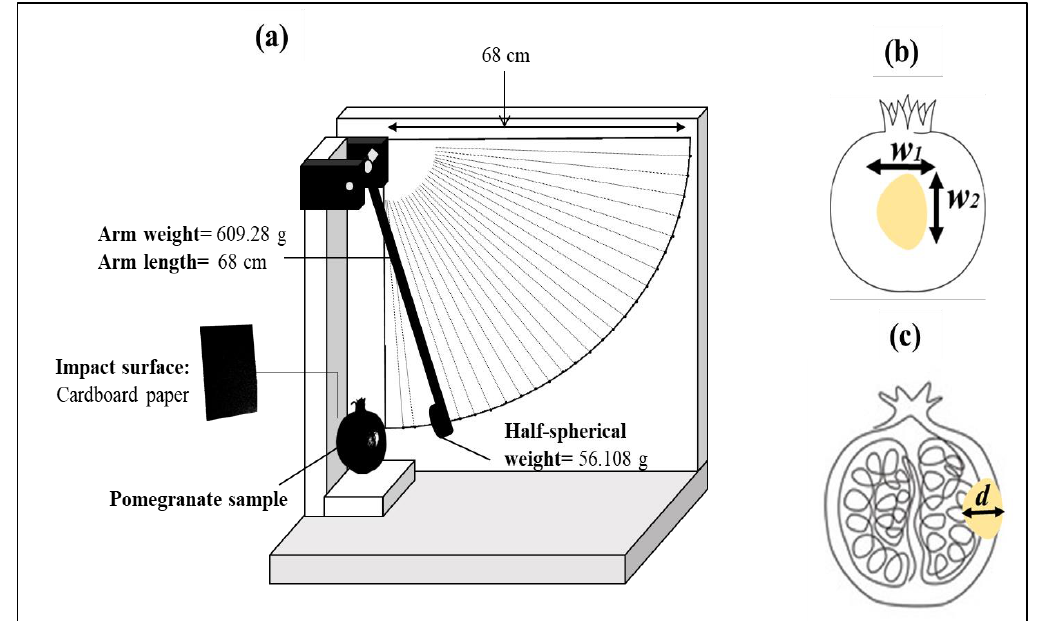
Figure 1. The pendulum test setup ( a ), bruised pomegranate fruit with bruise diameter indicated ( w 1 and w 2 ) ( b ), and sliced pomegranate fruit showing the bruise depth (d) ( c ). The center of the bruised region (marked area) of each damaged pomegranate fruit was sliced for bruise identification. The digital caliper (Model: Mitutoyo, Mitutoyo Corp., Kawasaki, Japan) was used to measure the major ( w 1 ) and minor ( w 2 ) diameters of the bruised region (Figure 1b), and the bruise depth ( d ) (Figure 1c). The findings of the bruise measurements were expressed as bruise area ( BA -mm 2 ) (Equation (2), bruise